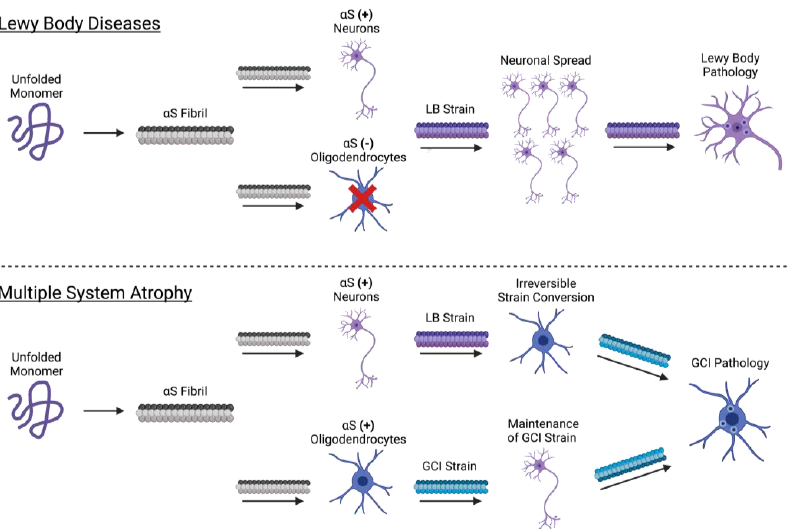
Figure 2. α S strains. Pathologically, α S aggregation results in the formation of amyloid fibrils with prion-like properties. Conformationally distinct populations of α S fibrils exist, termed “strains”. In vivo, cell-type-specific factors determine the α S strain(s) formed. The propagation of different α S strains leads to distinct pathologic patterns of spread and, therefore, the distinct clinical manifestations of the synucleinopathies. In Lewy body diseases (i.e., LBD and PD) (top panel), the infection of a neuron with α S fibrils results in templated aggregation of α S monomer and, due to neuron-specific cell factors, the formation of the LB strain of α S. The cell-to-cell spread of the LB strain results in the characteristic lipid- rich cytoplasmic inclusions in neurons termed Lewy bodies. In MSA (bottom panel), oligodendrocytes abnormally express or extracellularly acquire α S. The infection of these α S-expressing oligodendrocytes results in the formation of the GCI-strain of α S. Likewise, the infection of neurons results in the formation of the LB-strain of α S. However, oligodendrocytes irreversibly convert the LB-strain to the GCI-strain, whereas neurons are incapable of the reverse process (GCI-strain to LB-strain). Thus, the GCI-strain becomes the predominant α S strain, the cell-to-cell spread of which results in the characteristic glial cytoplasmic inclusions of